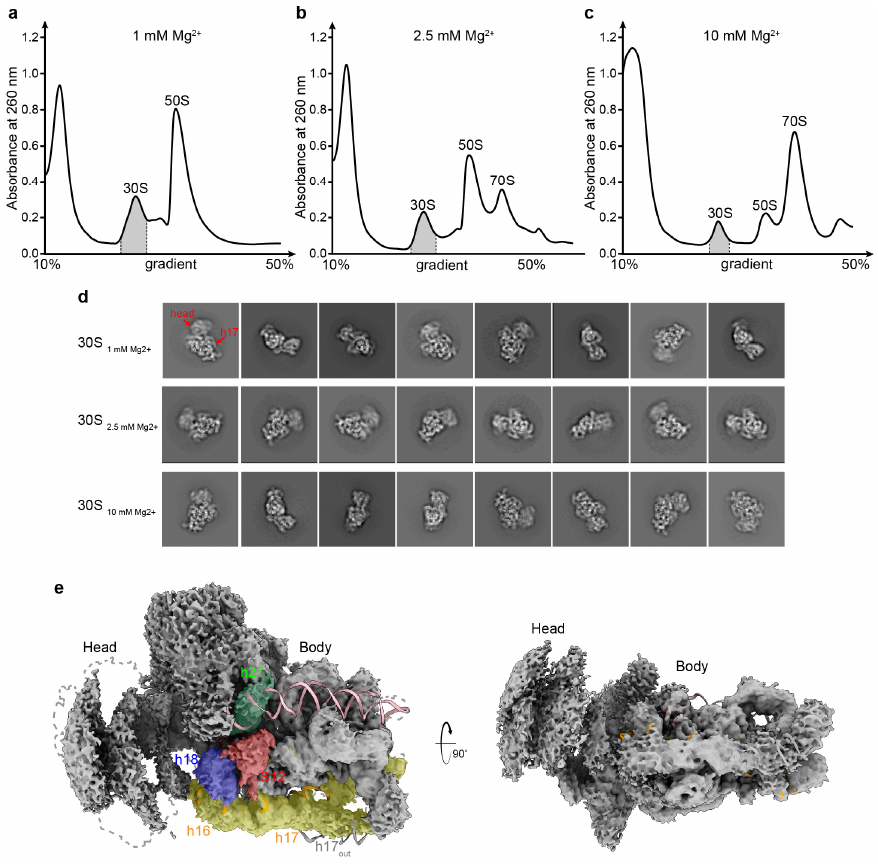
Figure 2. A 30S subunit at 1 mM Mg 2+ has a flexible h44, h17, decoding center, and head. ( a – c ) Sucrose gradient sedimentation profile of E. coli ribosomes under 1 mM ( a ), 2.5 mM ( b ), and 10 mM ( c ) Mg 2+ conditions. The 30S peak indicated in gray shadow was collected separately for cryoEM analysis. ( d ) Reference-free 2D classification averages for 30S particles under different conditions, as shown in ( a – c ). The flexible h17 and head are labeled with red arrows. ( e ) The overall structure and map of a 30S subunit at 1 mM Mg 2+ concentration are represented in cartoon and surface, respectively. The rRNA helices h16/h17, h18, h27, and h44 and the S12 protein are colored in yellow, blue, green, magenta, and red. The dashed line represents the mature 30S under 10 mM Mg 2+ conditions in this